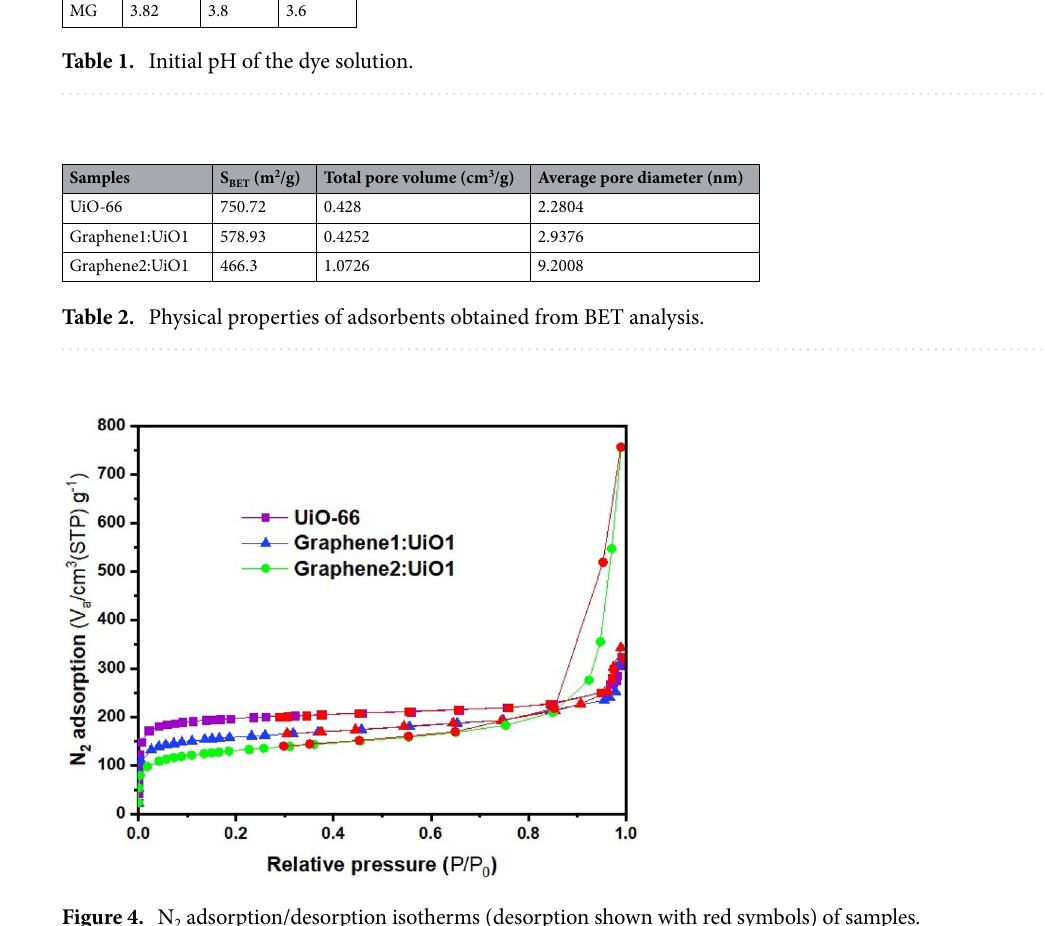
Figure 4. N 2 adsorption/desorption isotherms (desorption shown with red symbols) of